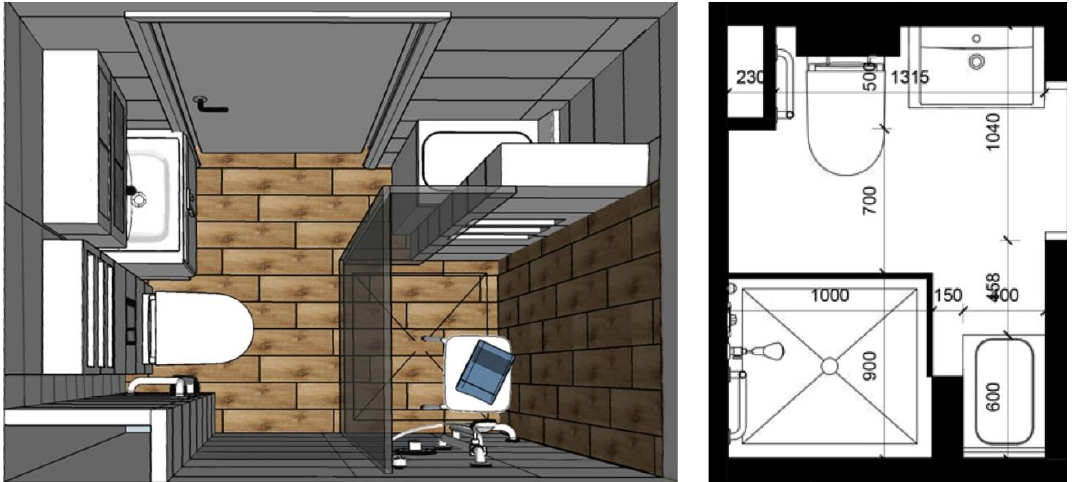
Figure 1. Bathroom arrangement project for an investor with dementia (picture: Students participating in the 8th edition of JAI).